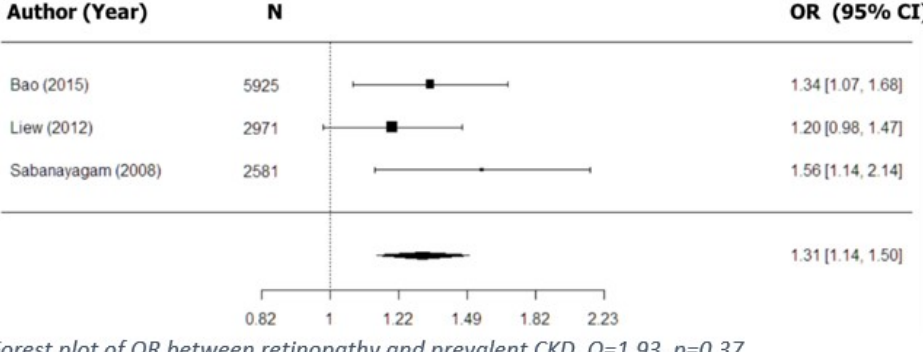
Figure 1. Cross-sectional associations between retinal vascular signs and kidney dysfunction. Table 3. Retinal microvascular signs and prevalent CKD.